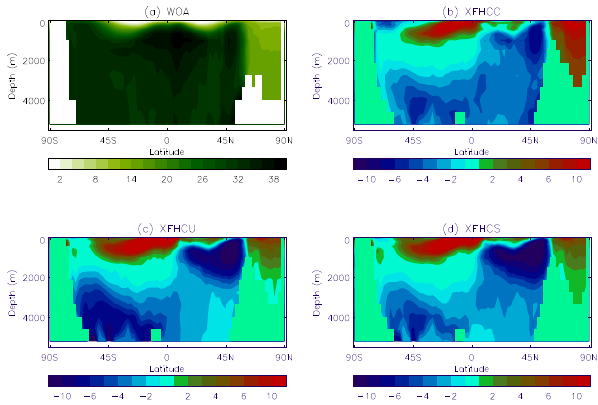
Fig. 15. Zonal mean–depth plots for annual mean nitrate concen- tration in mmol per m − 3 for (a) World Ocean Atlas observations (Garcia et al., 2006) and the difference between the simulated and observed values for (b) the generation 3 model XFHCC, (c) the gen- eration 4a model XFHCU, (d) the generation 4b model